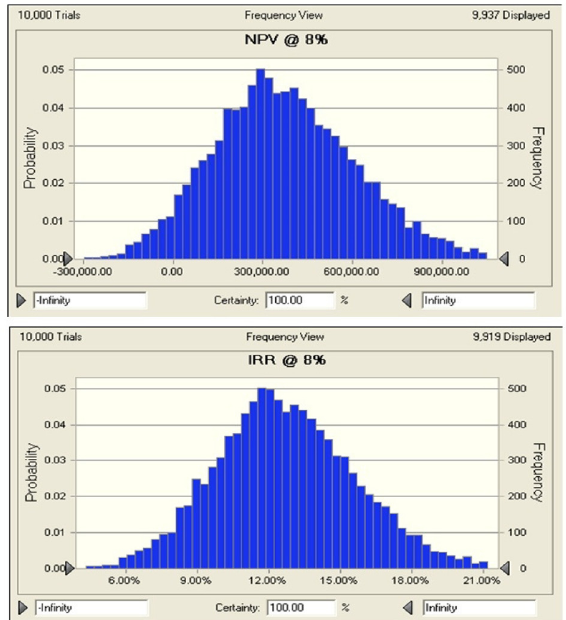
Fig. 1. Example frequency probability distributions of NPV and IRR